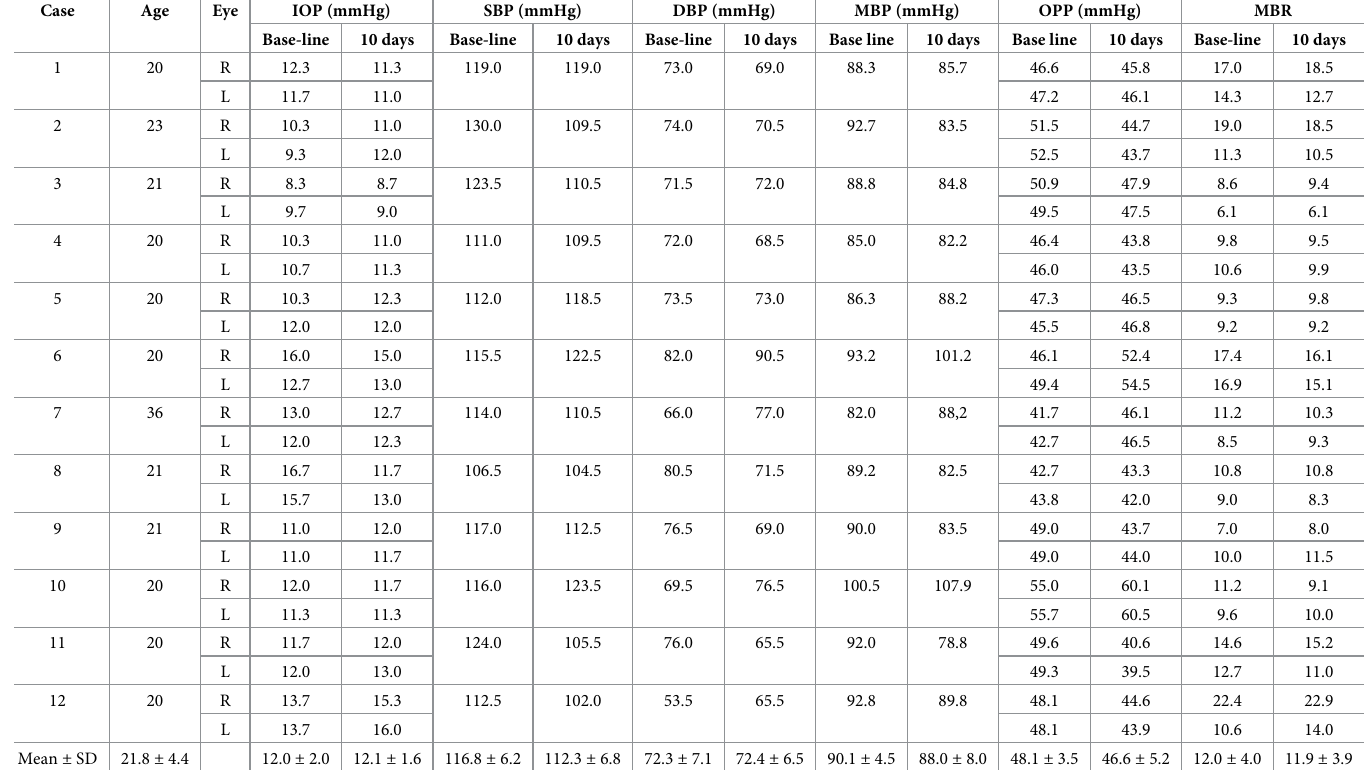
Table 2. Characteristics of and changes in intraocular pressure and systemic factors in male